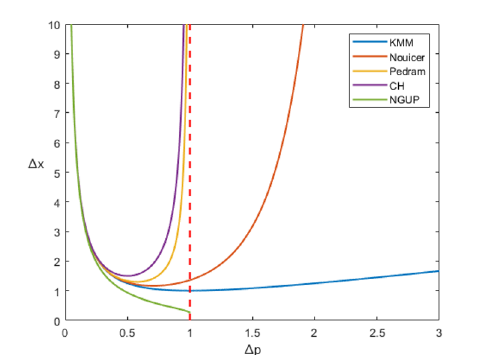
Figure 1 . The ∆ x as the functions on ∆ p for β > 0 respectively given by KMM, Nouicer, Pedram, CH and NGUP. The red dotted line represents the position of the maximum